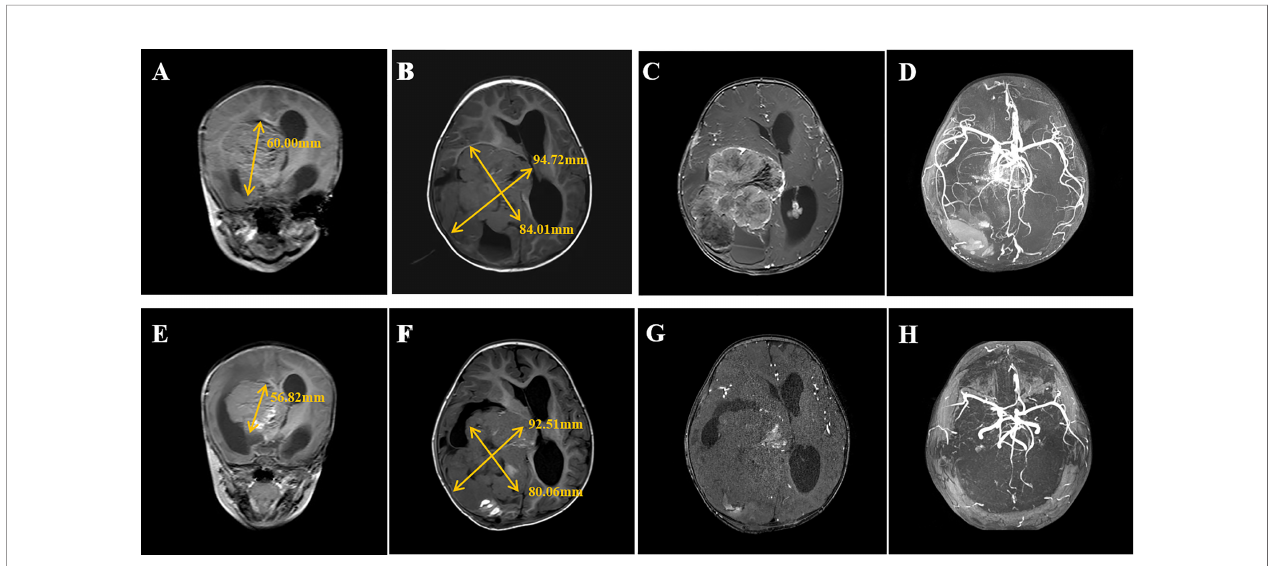
FIGURE 2 | Serial intracranial MR images of the patient. Panel 1 Coronal (A) and transverse (B) T2-weighted MRI of the patient showed the tumor size in the right lateral ventricle and (C, D) MRA displayed the tumor with abundant blood supply (high-signal intensity) at admission (May 4, 2021). Panel 2 Coronal (E) and transverse (F) T2-weighted MRI showed a slight decrease in tumor size and (G, H) MRA displayed signi fi cant decrease of blood supply (high-signal intensity) to tumor after 14 days of oral rapamycin treatment (May 21,